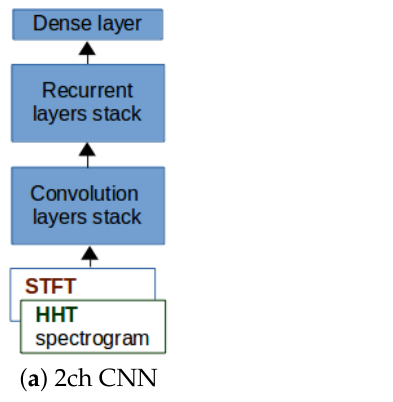
Figure 3. A schematic representation of ‘naive’ combinations of two